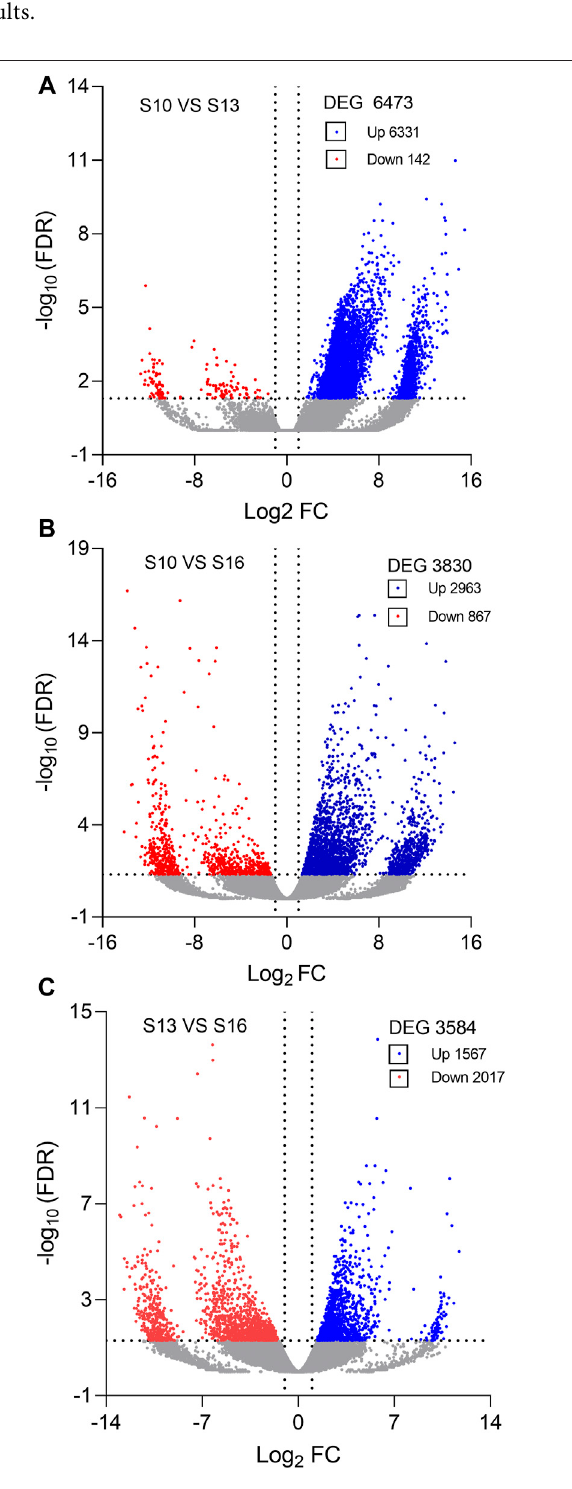
FIGURE2| Volcano plotsof differentially expressed genes(DEGs) in the S10 vs. S13 comparison (A) , S10 vs. S16 comparison (B) and S13 vs. S16 comparison (C)